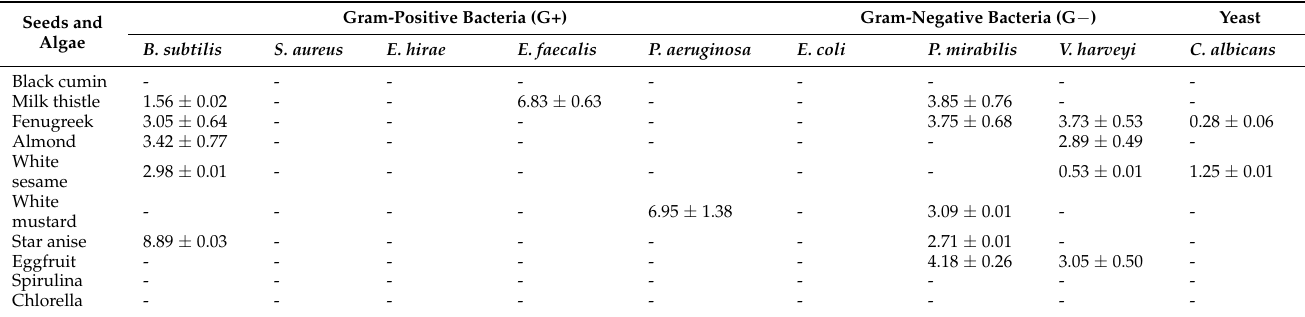
Table 1. Zones of inhibition (mm) of the growth of microorganisms in the analyzed plant